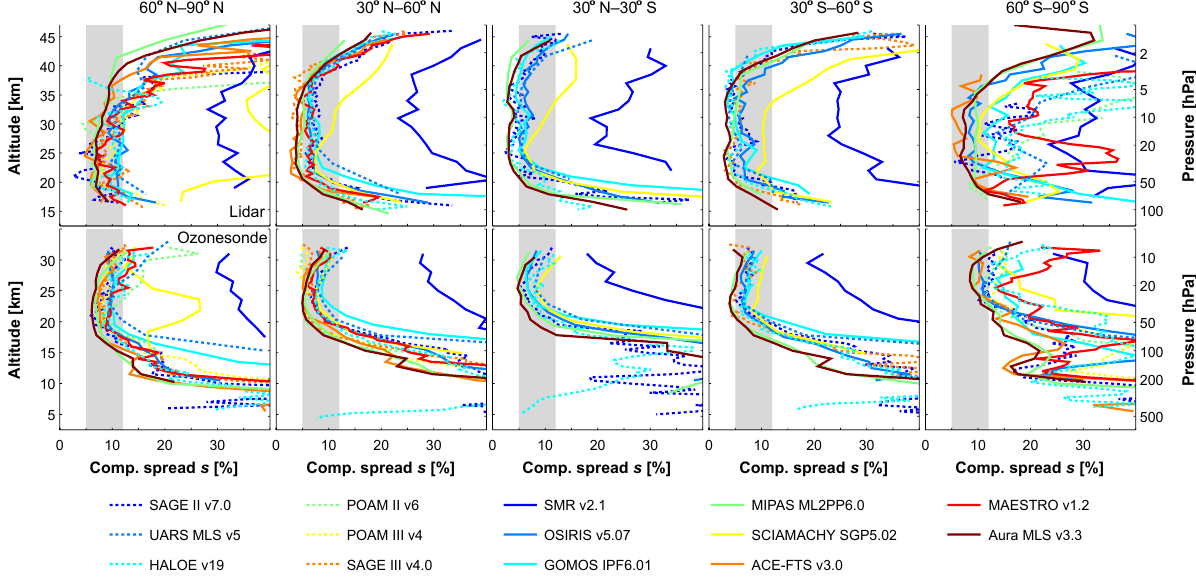
Figure 11. Similar as Fig. 10, but for the comparison spread s . The spread is mostly between 5 and 12% (grey shaded area) in the middle and upper